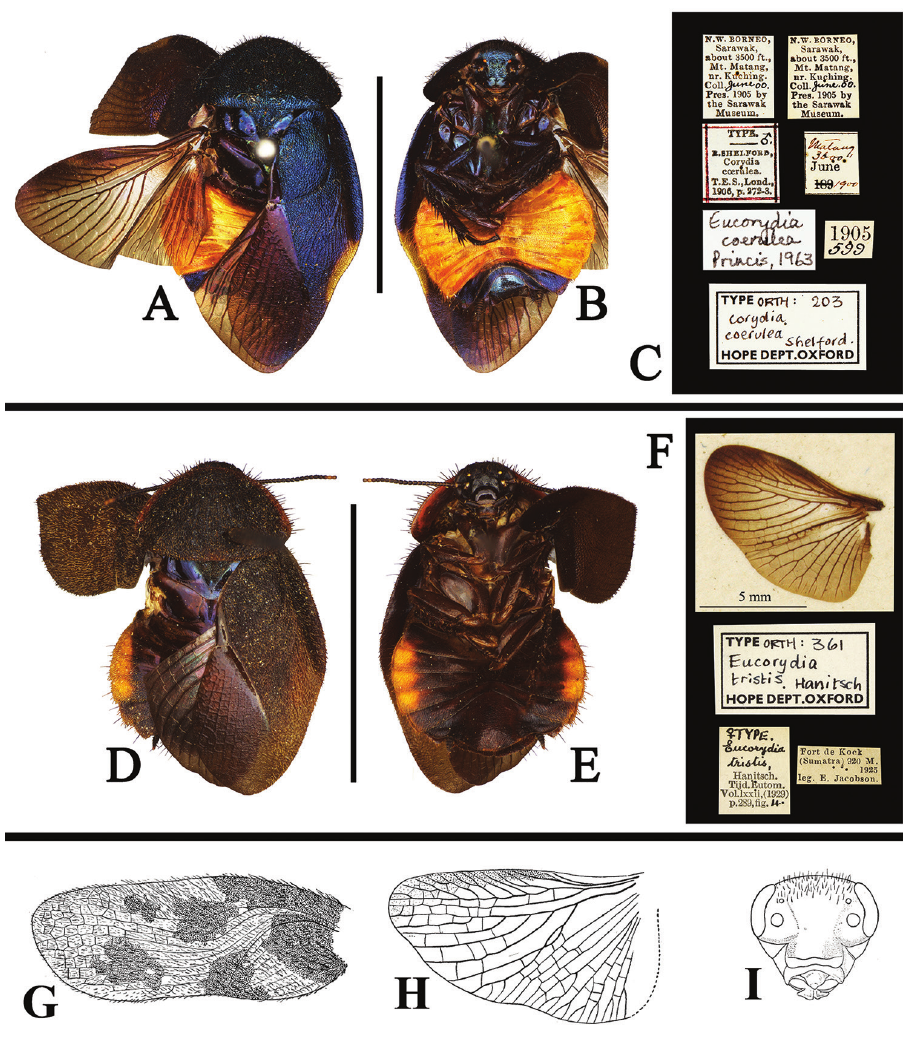
Figure 12. A–I Eucorydia species outside China A–C holotype of Corydia coerulea , male D–F holotype of Eucorydia tristis , female [A–F photographed by Katherine Child and provided by Amoret Spooner, copy- right Oxford University Museum of Natural History, Oxford (OUM)] G–I original figures of Eucorydia multimaculata in Bruijning (1948), male: G tegmen H wing I head. Scale bars 10